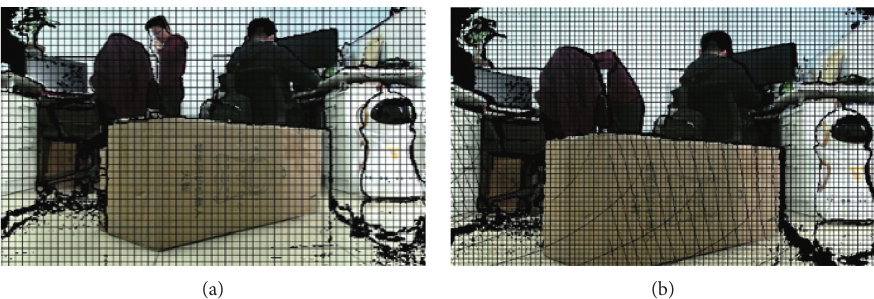
Figure 1: Calibration results between RGB and depth of Kinect. (a) Camera data cannot be aligned before calibration. (b) After calibration, the depth image can be well-aligned with the color image.